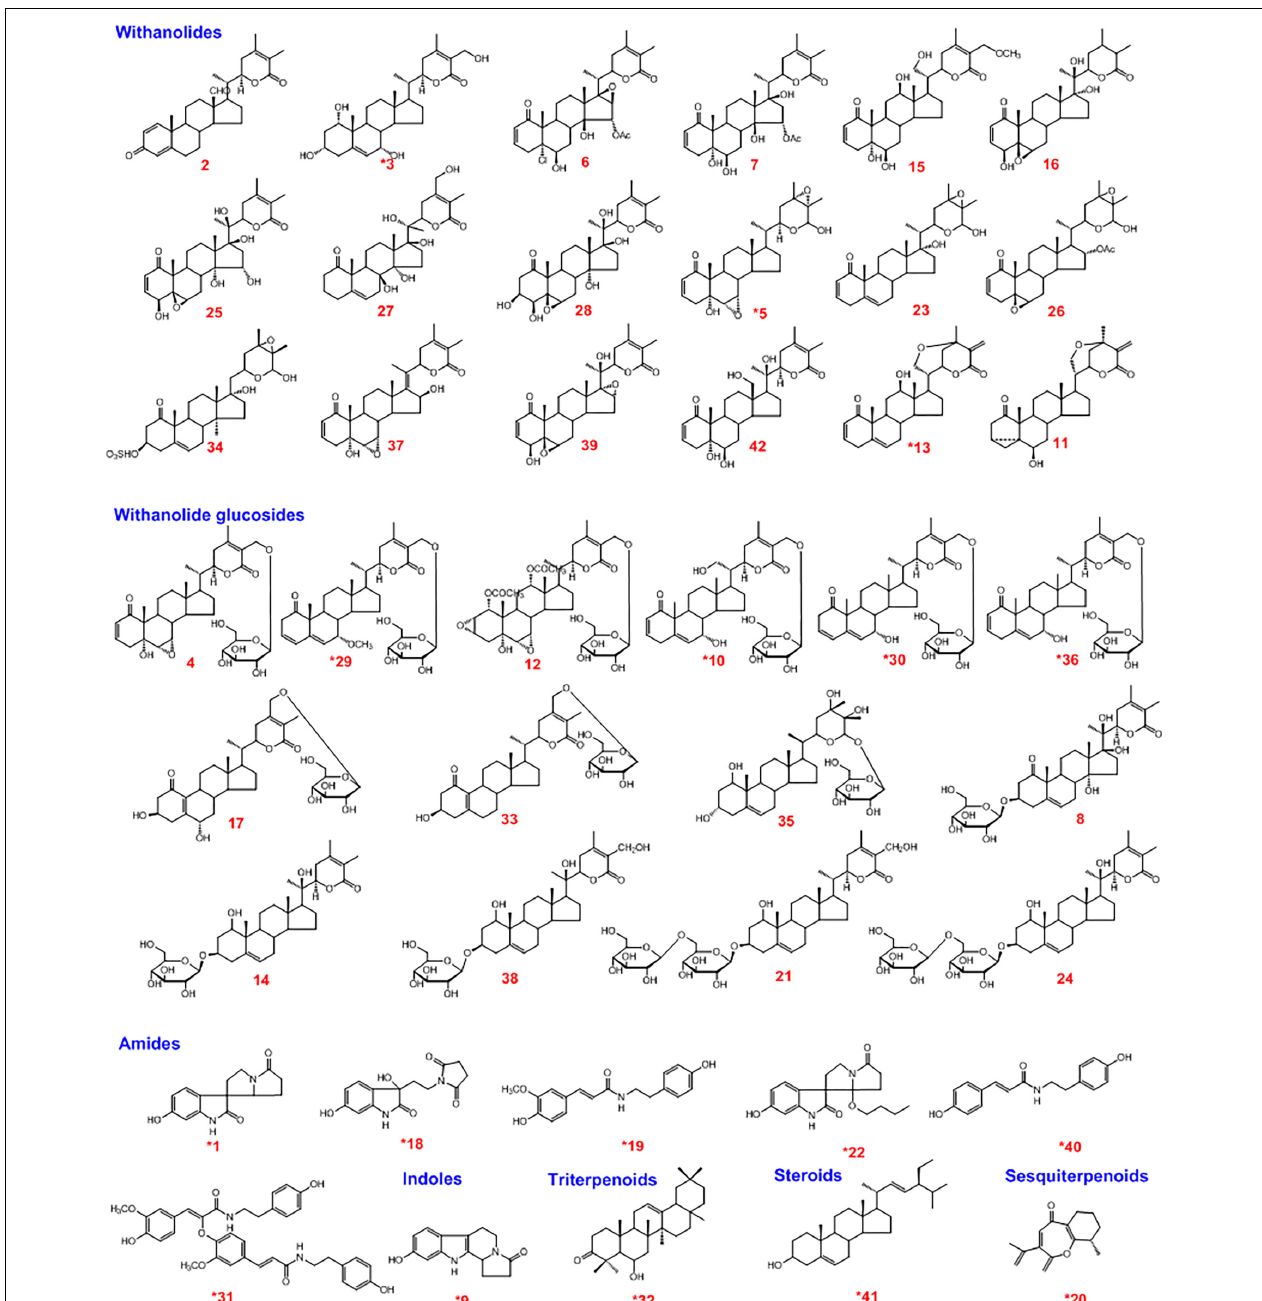
FIGURE 2 | Structure of the chemical constituents of the water extract of Datura metel seeds (WDS). ∗ Identified by comparing with reference